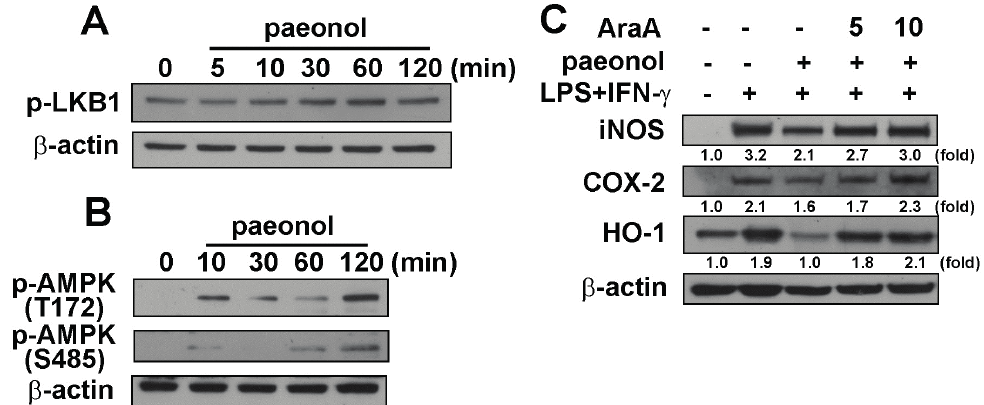
Figure 3. Involvement of AMPK by paeonol in neuroinflammation. BV-2 microglia cells were incubated with paeonol (10 μ M) for indicated time periods (0–120 min). Whole-cell lysates were subjected to western blot analysis using antibodies against the phosphorylated LKB1 (Ser 428 ) ( A ); and phosphorylated AMPK α at Thr 172 and Ser 485 ( B ); ( C ) Cells were pretreated with AraA (5 or 10 μ M) for 30 min and incubated with paeonol (10 μ M) for another 30 min before LPS (10 ng/mL)/IFN- γ (10 ng/mL) treatment for 24 h; Whole